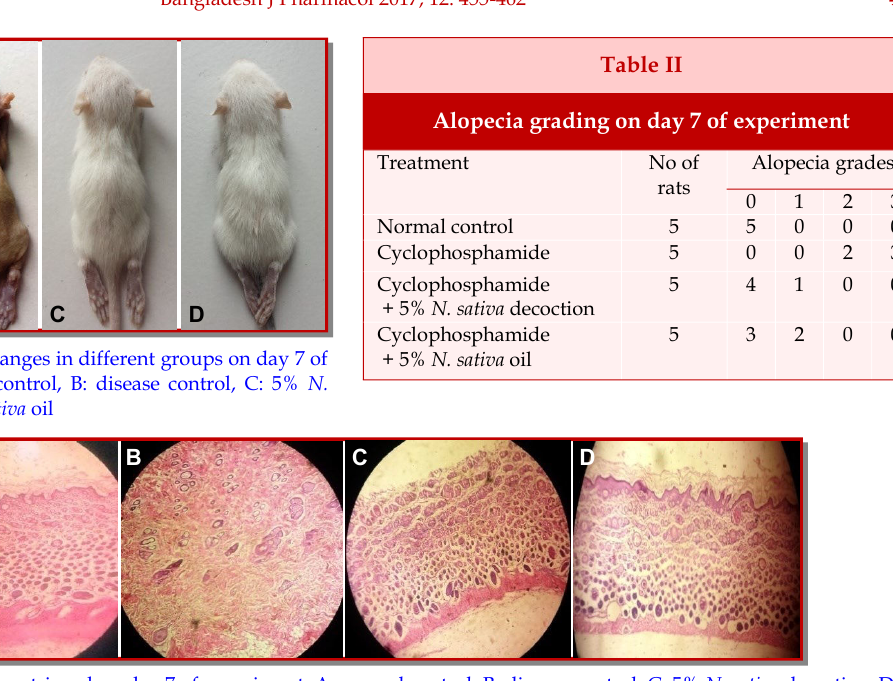
Figure 7: Photomicrograph retrieved on day 7 of experiment; A: normal control, B: disease control, C: 5% N. sativa decoction, D: N. sativa